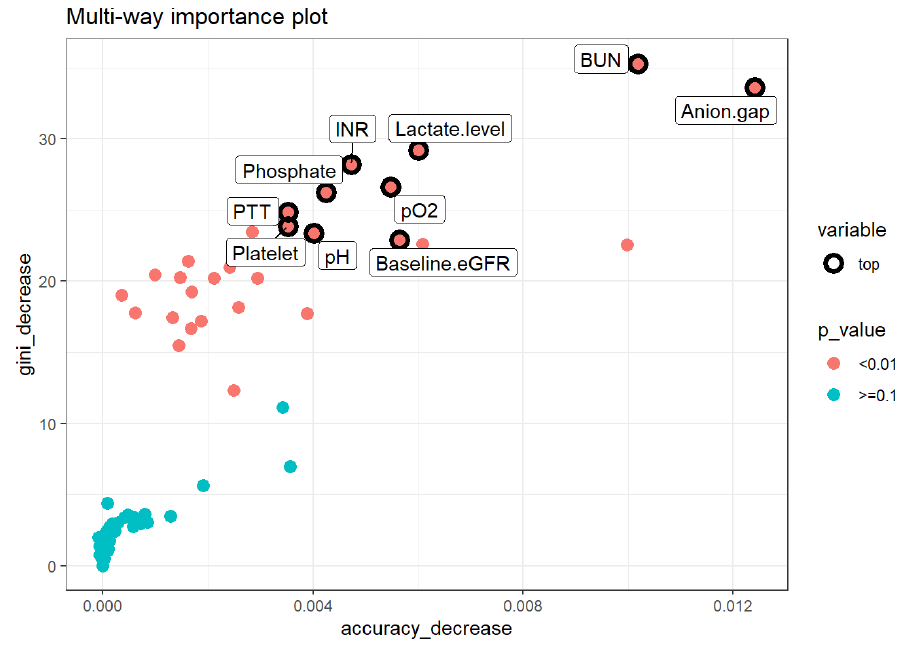
Figure 3. Multiway feature importance analysis of RF model combining the mean decrease in Gini, decrease in accuracy, and p values of the features (pink circle; p < 0.01). Abbreviations: BUN, blood urea nitrogen; eGFR, estimated glomerular filtration rate; pH, potential hydrogen; pO2, partial pressure of oxygen; PTT, partial thromboplastin time. To identify the features that influenced the prediction model the most, we depicted the SHAP summary plot of RF model (Figure 4) and the top 20 features of the prediction model. This plot depicts how high and low features’ value s were in relation to SHAP val- ues in the testing dataset. According to the prediction model, the higher the SHAP value of a feature, the higher probability of mortality occurring. Additionally, we applied LIME into RF model to illustrate the impact of key features at the individual level (Figure 5).